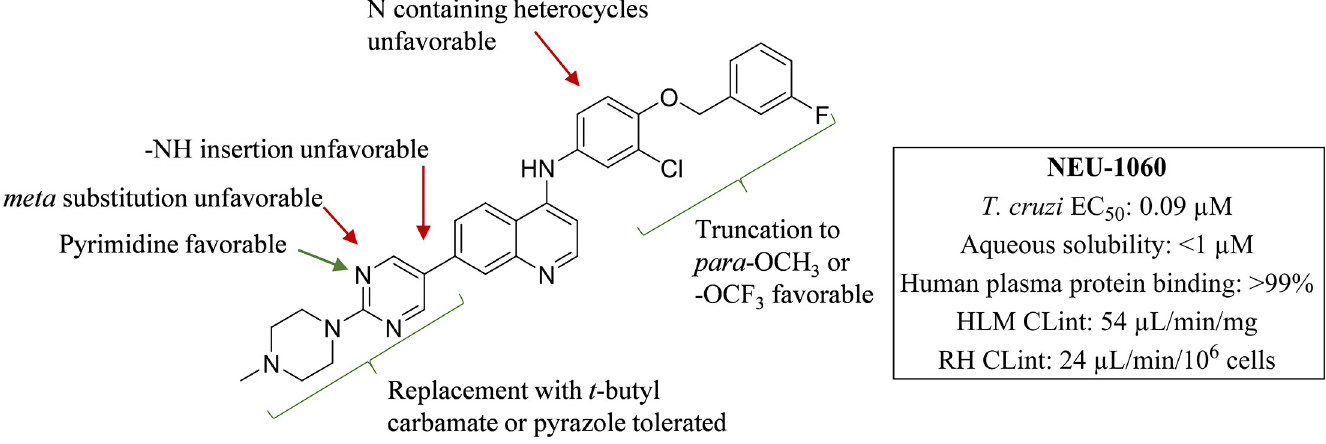
Fig 5. SAR summary around this series for potent anti- T . cruzi activity.